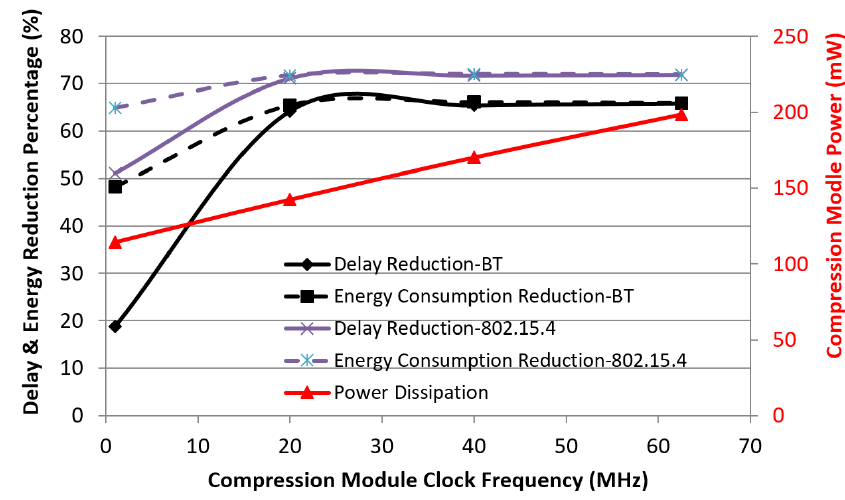
Figure 8. Compression module performance effect wrt ECG_EkgMove/shimmer BT setup.